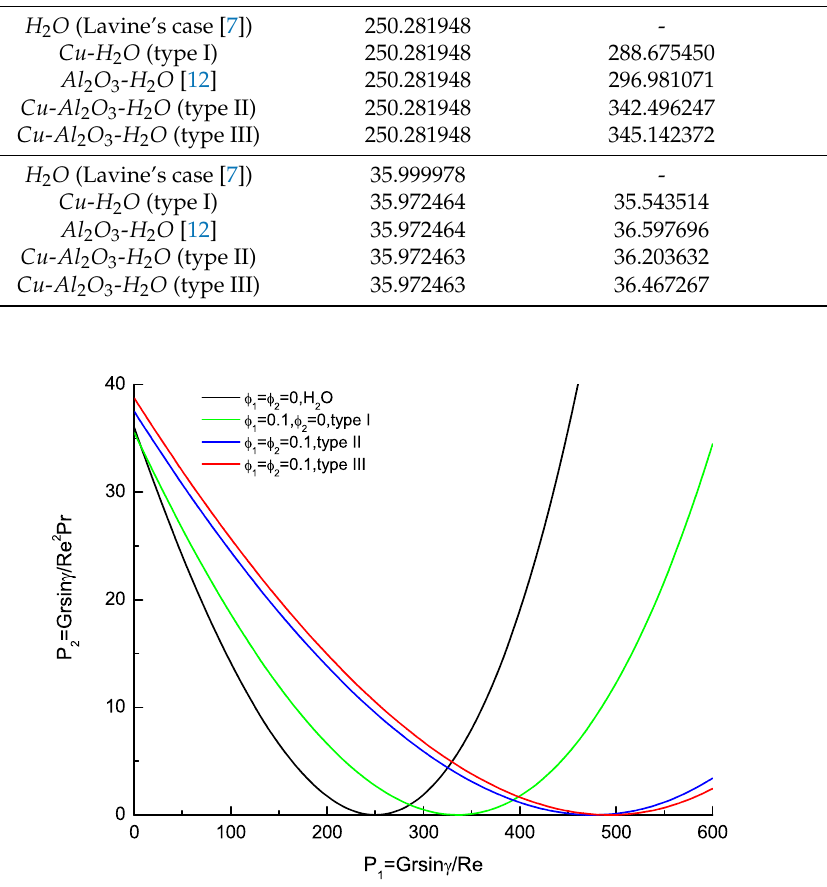
Figure 2. Flow regime map of the base fluid ( H 2 O ), nanofluid ( Cu - H 2 O ,type I) and hybrid nanofluid ( Cu - Al 2 O 3 - H 2 O ,type II and